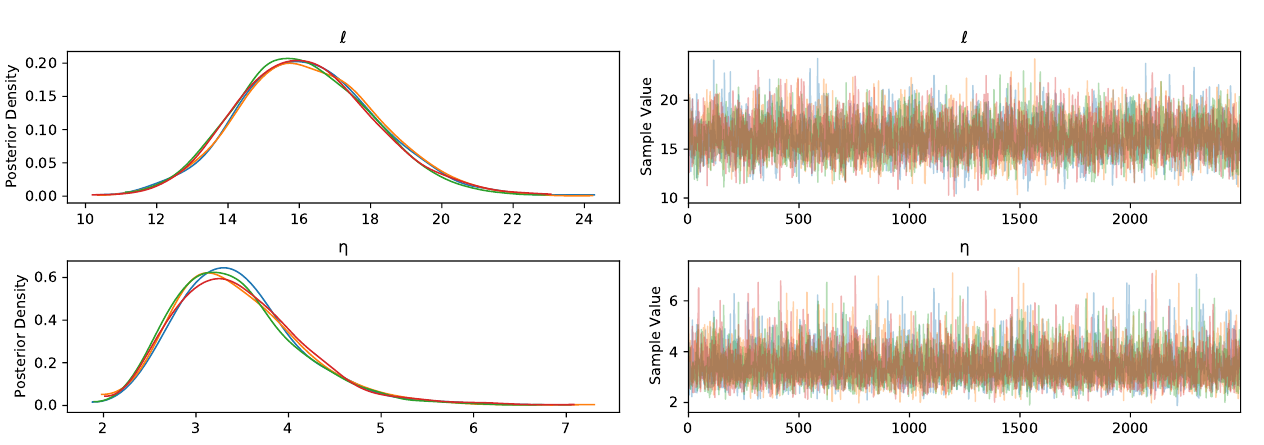
Figure 7. Posterior distributions and trace plots for the North Dakota detection count model. Well mixing and convergence are achieved. Note the differences between these results and those in Figure 5, both of which are based on the same priors and likelihood, demonstrating the model specification’s wide applicability.